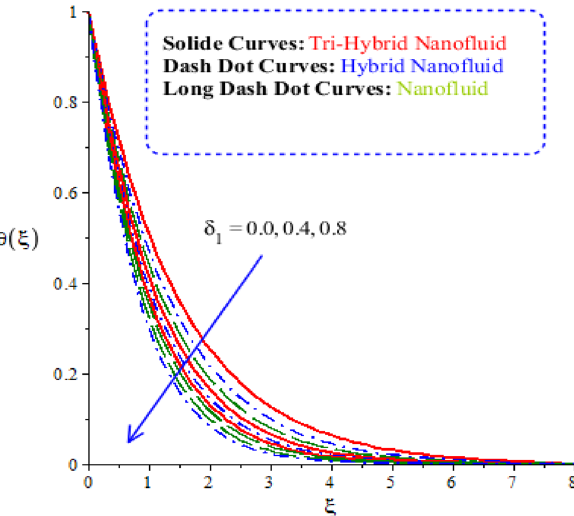
Figure 10. Comparative variation of temperature curves among nanoparticles versus δ 1 .